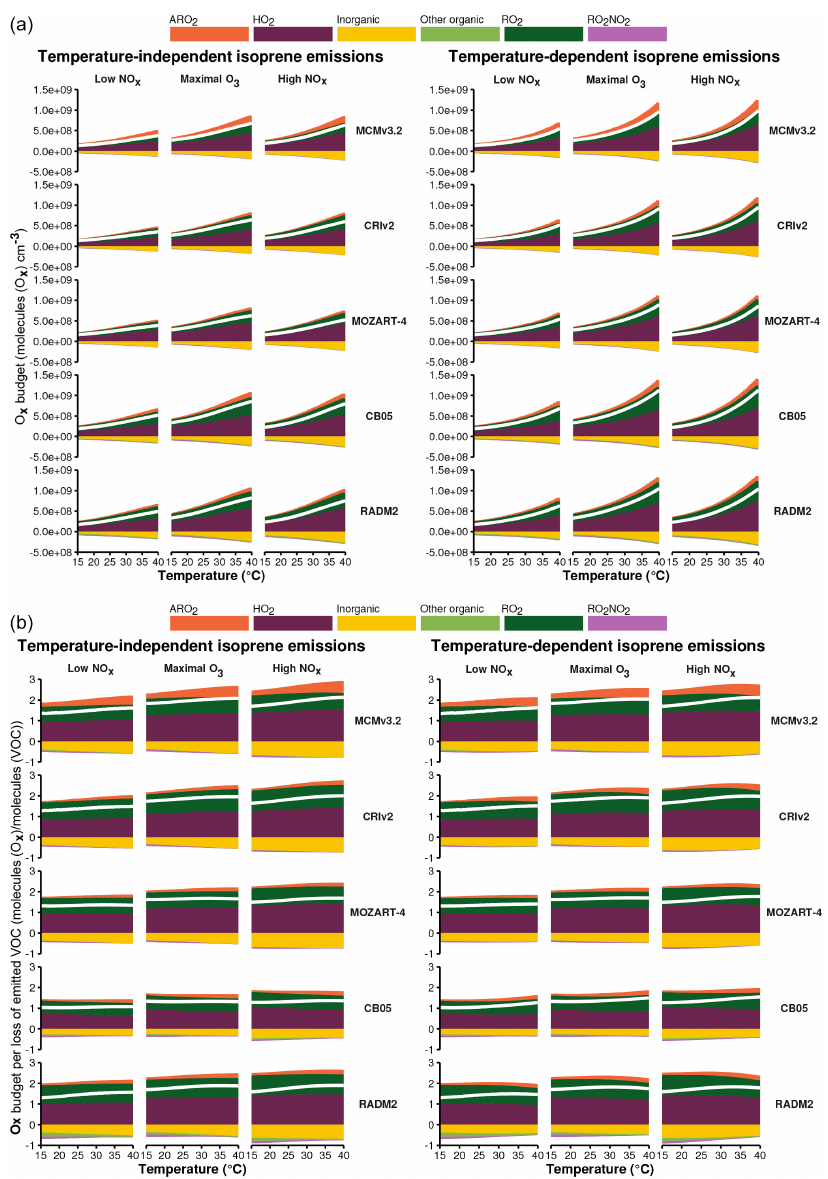
Figure 4. Daytime production and consumption budgets of O x in the NO x regimes. The white line indicates net production or consumption of O x . The net contribution of reactions to O x budgets is allocated to categories of inorganic reactions, peroxy nitrates (RO 2 NO 2 ), reactions of NO with HO 2 , alkyl peroxy radicals (RO 2 ) and acyl peroxy radicals (ARO 2 ). All other reactions are allocated to the “other organic” category. (a) O x production and consumption budgets. (b) O x production and consumption budgets normalised by the total loss rate of emitted